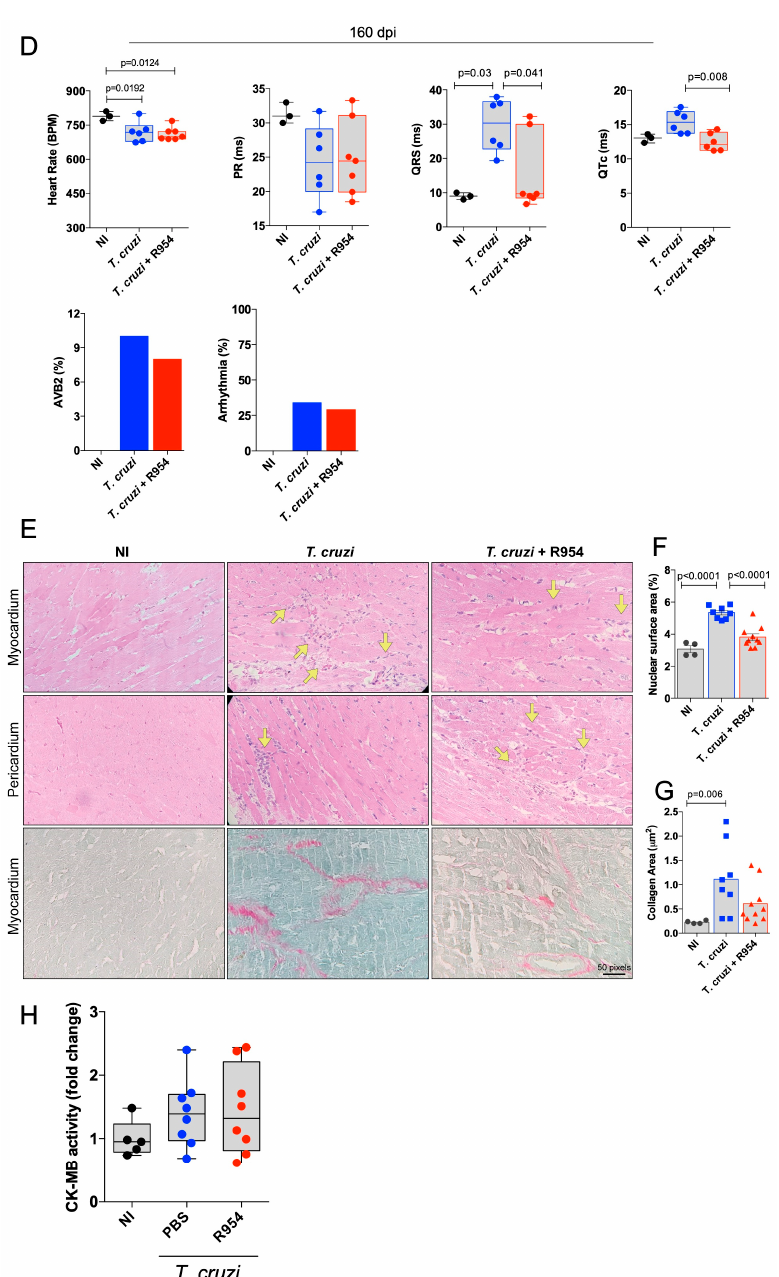
Figure 4. Therapeutic application of B1R antagonist reverses chronic chagasic cardiomyopathy ( A ) Schematic figure of the infection model and treatment protocol. C57BL/6 (WT) mice were systemically infected (i.p.) with Col TCTs (10 2 parasites). Daily R-954 treatment (1.6 mg/kg—s.c.) started at 120 days pi. and lasted up to 160 days pi., whereas the control mice received PBS. ( B , D ) Electrocardiogram registers were performed at 120 (( B ); before treatment) and 160 dpi (( D ); after treatment) in awake mice. The parameters were heart rate (bpm), PR interval, QRS, QTc, AVB2, and frequency of arrhythmias. ( C ) Survival rate was followed daily. ( E – G ) At 160 dpi, hearts sections were stained by H & E to evaluate the area of cardiac tissue presenting cellular nucleus. The yellow arrows indicated the presence of inflammatory infiltrate. ( F ) or were stained by Picrosirius Red to evaluate fibrosis (collagen area) ( G ). ( H ) CK-MB activity was quantified in the serum and the results expressed by fold change. The results are representative of two independent experiments; the bar shows media ± SD and each symbol represents one mouse (n = 8–10 mice/group/experiment). Statistical analysis was performed by one-way analysis of variance (ANOVA) test. p values < 0.05 were considered